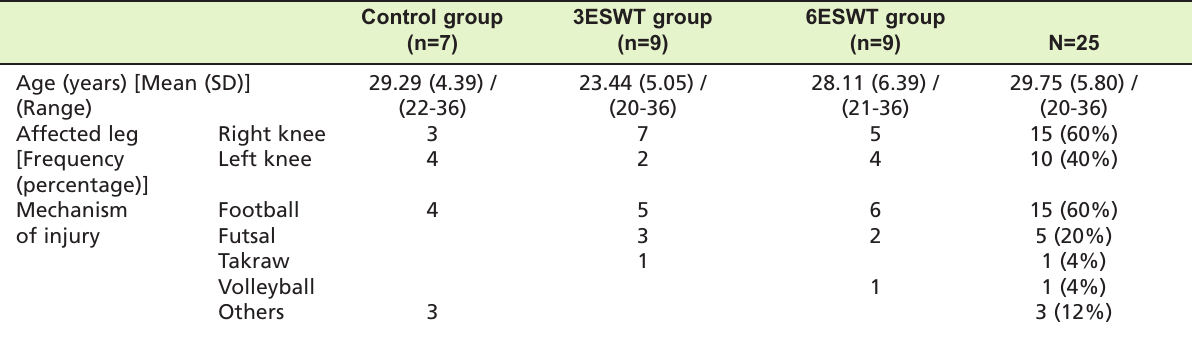
Participants’ demographic Table I: